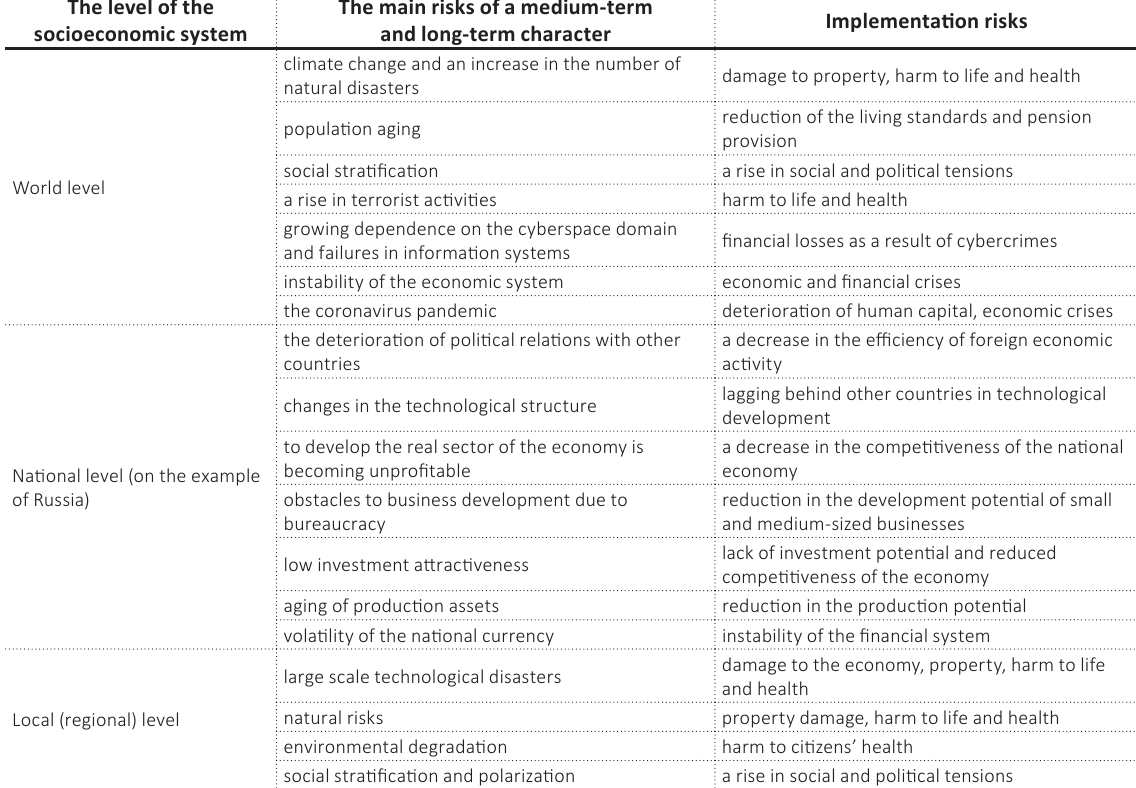
Table 1. Main risks at different levels of the economic